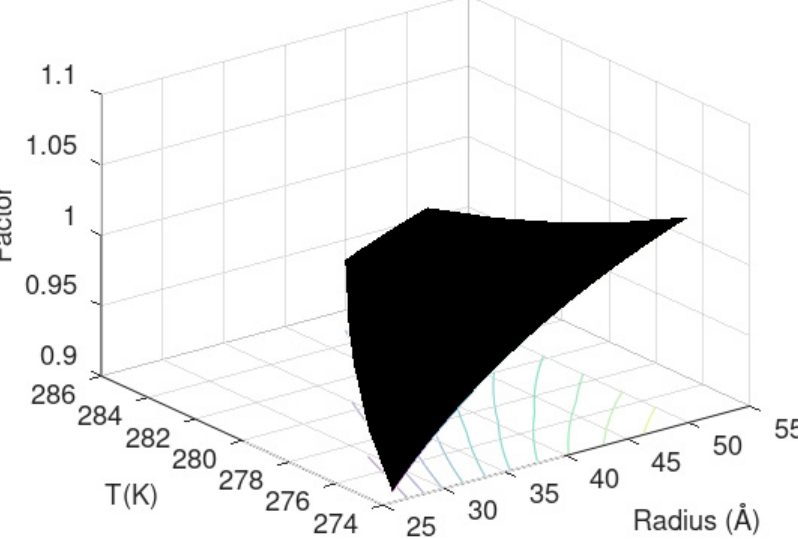
Figure 19. Thermodynamic factor for hydrate growth as function of temperature and radius after critical size.